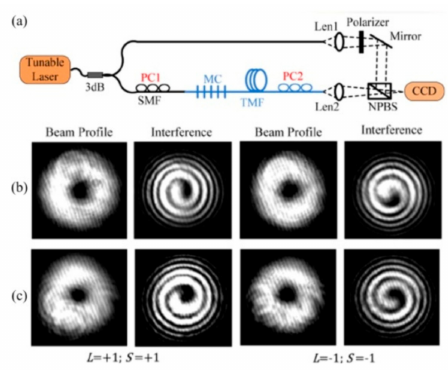
Figure 24. ( a ) Experimental setup used to excite the OAM modes; beam profile and interference patterns of the generated OAM modes using ( b ) SLPFG and ( c ) tilted SLPFG, respectively